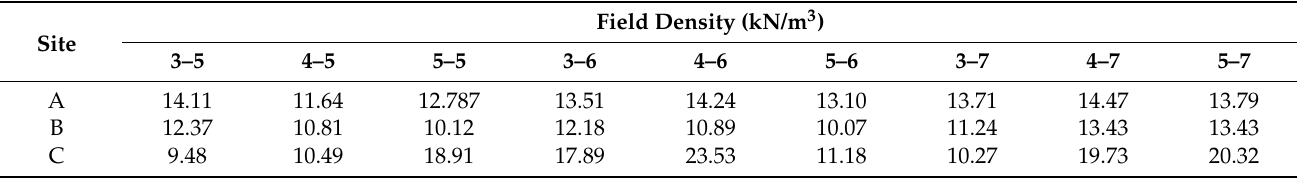
Table 4. Field dry unit weight on site A, site B, and site